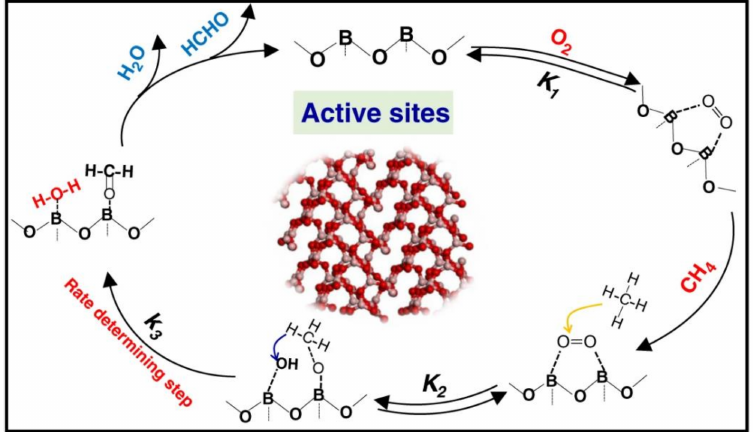
Figure 10. Schematic diagram of the plausible pathway of partial oxidation of methane to formalde- hyde on B 2 O 3 catalysts [36]. Copyright 2020, with permission from